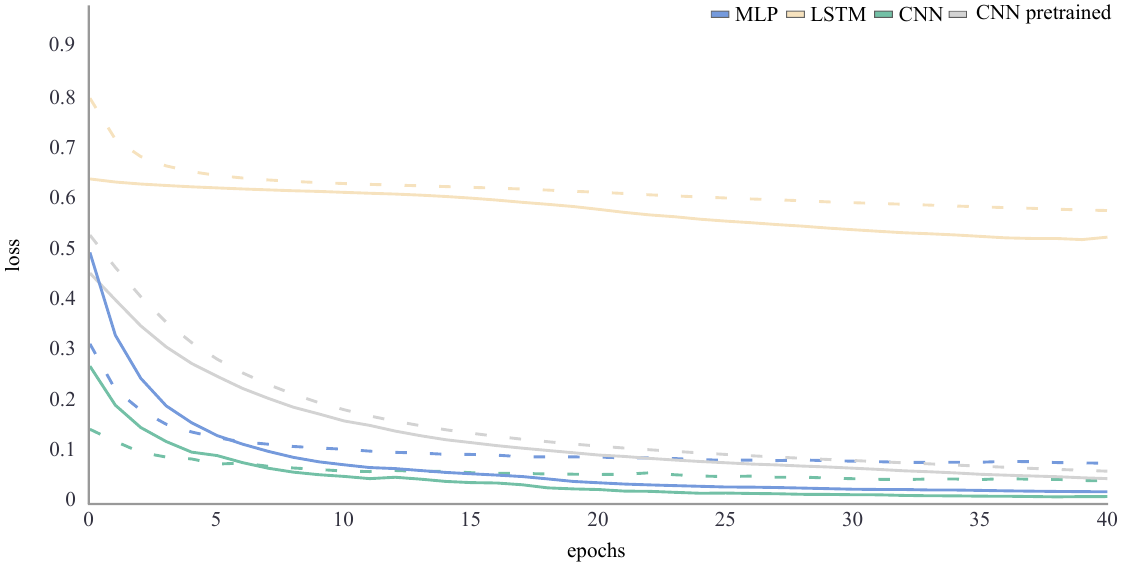
Figure 4. Loss curve of the joint angle training process of an exemplary LOSO validation for all ANNs. The training loss is displayed by a dashed line, while the validation loss is displayed by a solid line.